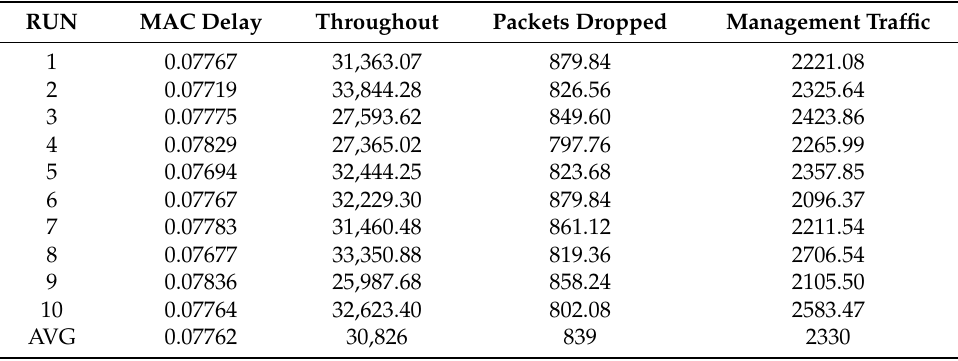
Table 8. Randomized Scenario Counting